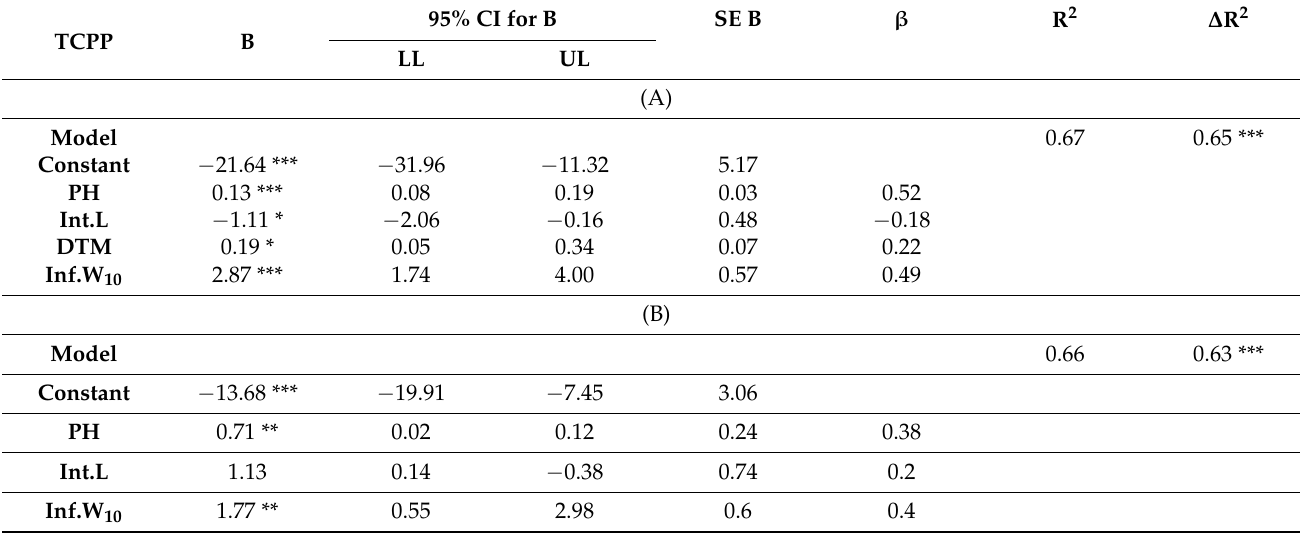
Table 4. Multiple regression analysis for the prediction of total cannabinoids per plant (TCPP). (A) Regression coefficients and standard errors for high-THC genotypes ( n = 74); (B) regression coefficients and standard errors for blended THC:CBD genotypes ( n =